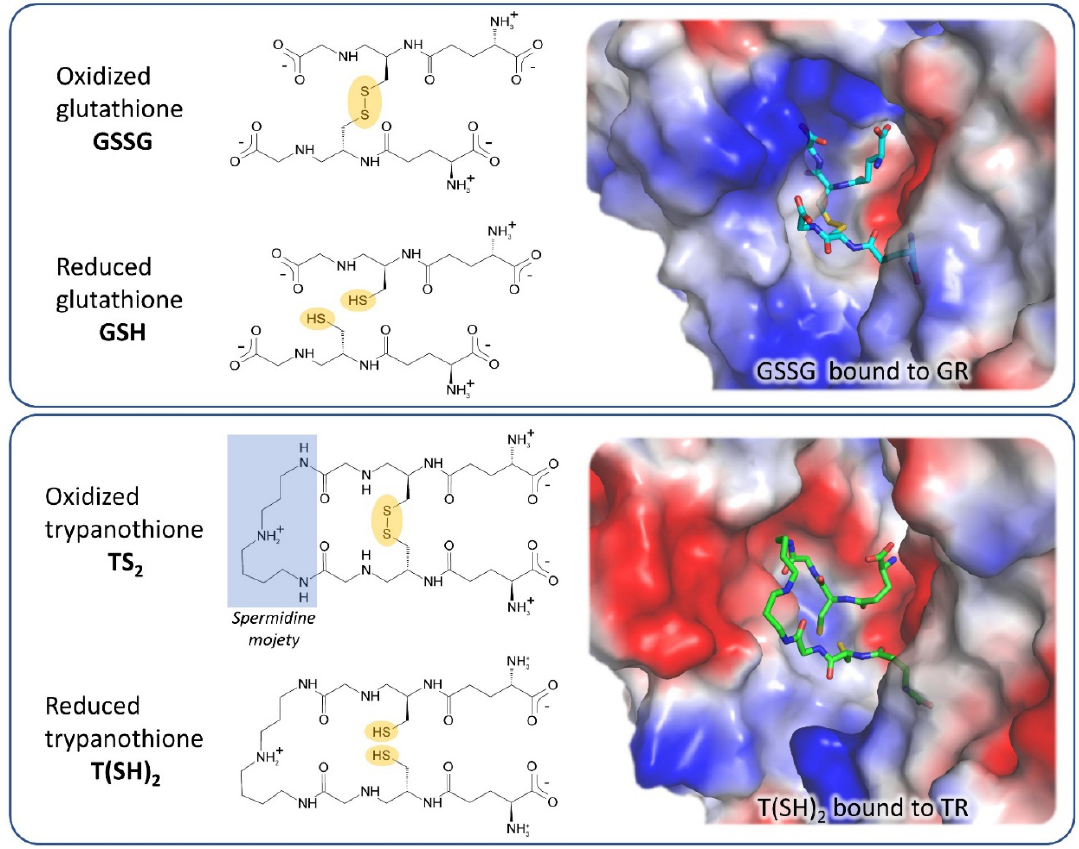
Figure 2. Substrates and active site of glutathione reductase (GR) and TR. The comparison between the electrostatic potential surfaces of GR (upper panel, PDB: 1gra) and TR (lower panel, PDB: 1bzl) highlights the difference in size and charge of substrate binding sites, related to substrates features.